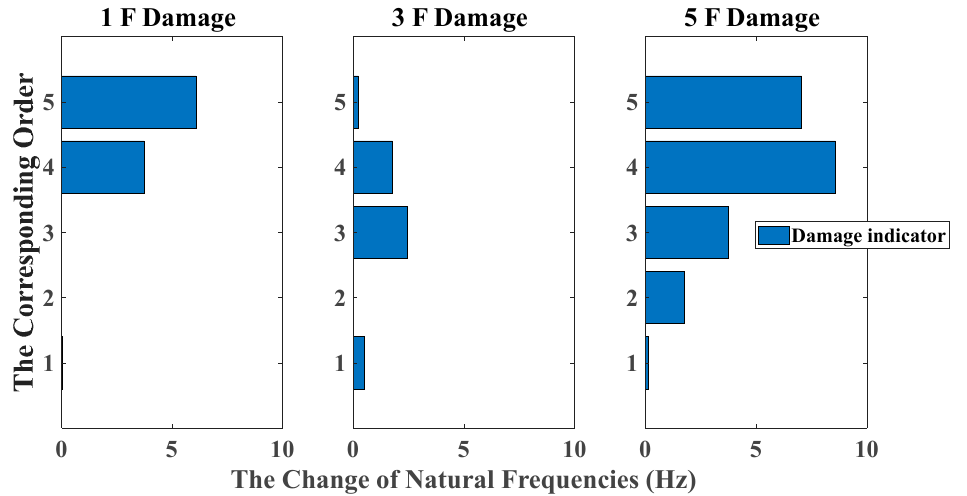
Figure 26. Damage detection results based on the change of natural frequencies (removing central columns, white noises excitation, data length = 4000).